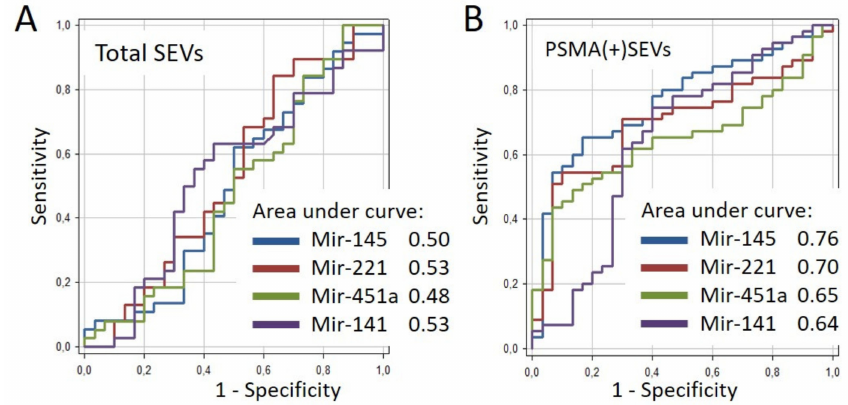
Figure 8. Evaluation of the diagnostic potential of the method. Receiver operating characteristic (ROC) curves for mir-145, mir-221, mir-451a, and mir-141 for total ( A ) and PSMA(+) ( B ) SEVs were created using the results from 85 samples: PC patients (n = 55) and healthy donors (n = 30) using Graph Pad Prism software.